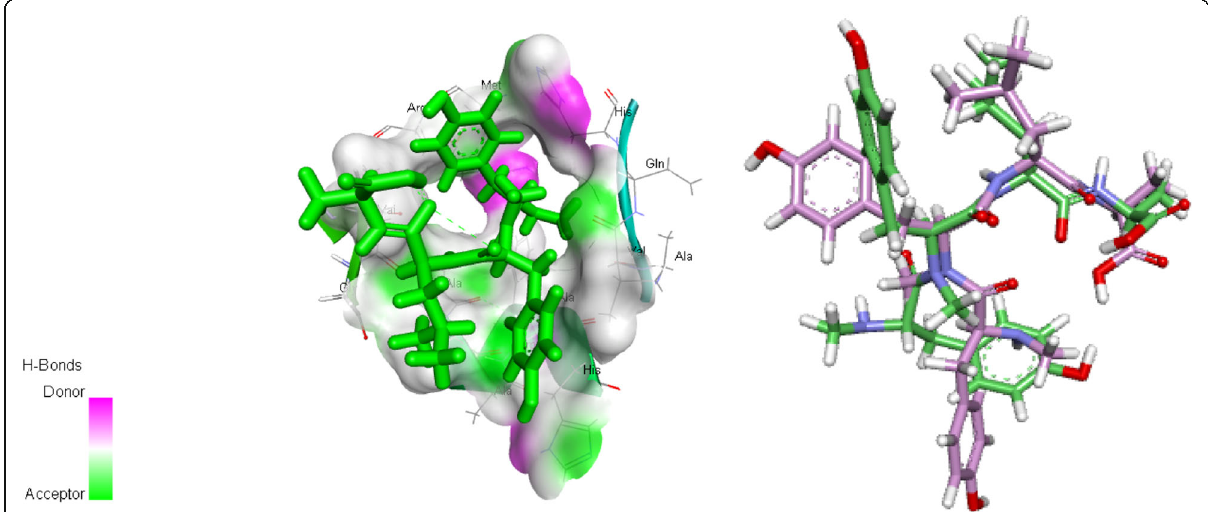
Fig. 8 a Orientation of UNPD86509 in binding site of GP63. b Ligand state alignment pre simulation(green) and post simulation